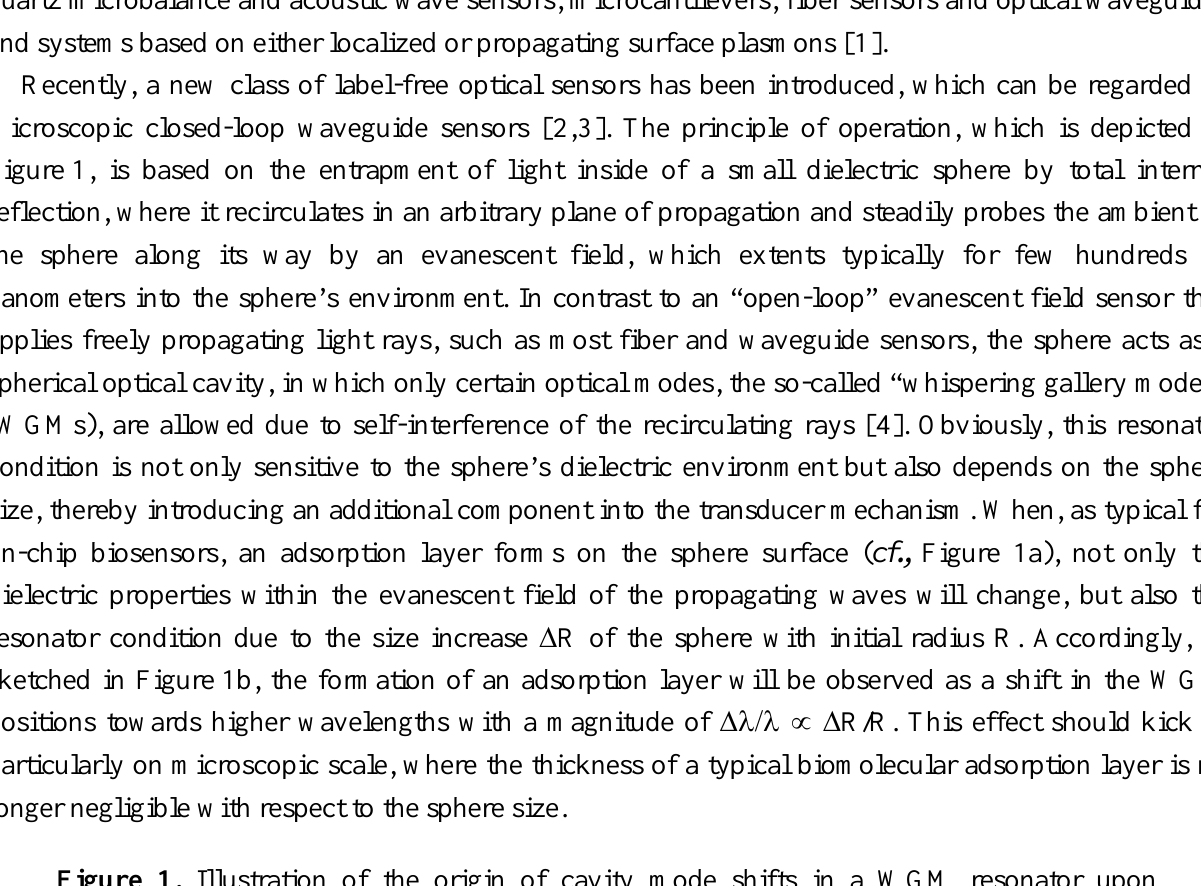
Figure 1. Illustration of the origin of cavity mode shifts in a WGM resonator upon biomolecular adsorption: (a) Effect of resonator size increase due to an adsorbate layer on whispering gallery mode (WGM) formation; (b) WGM wavelength shift due to formation of the adsorbate layer; (c) Definition of the two states of polarization for